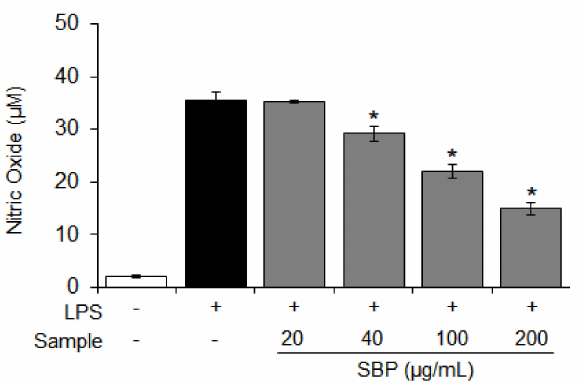
Figure 2. Effect of the SBP extract on production of nitric oxide in Raw264.7 cells. Data are expressed as mean ± SEM. Significantly different from the LPS − treated group (* p < 0.05). SBP, sword bean pod; LPS,